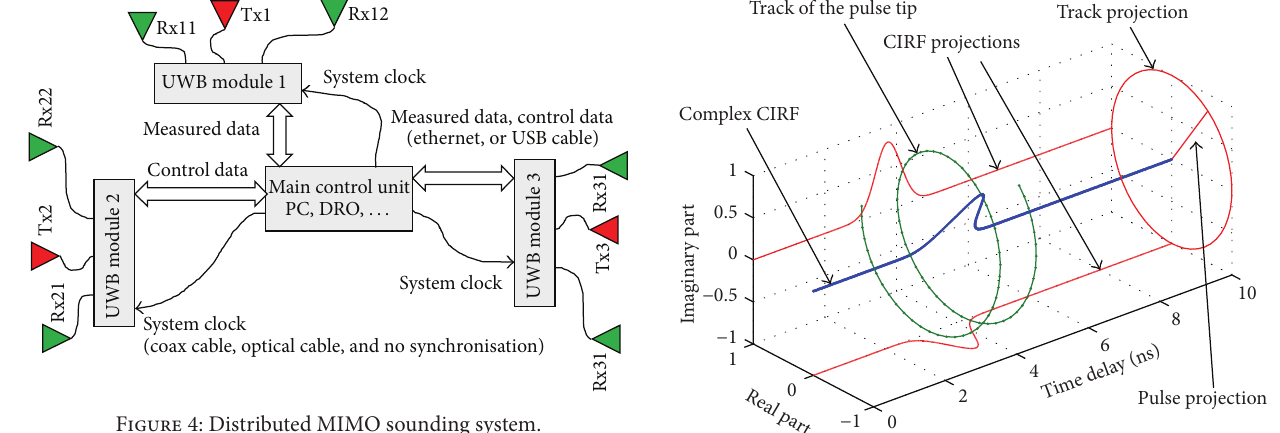
Figure 4: Distributed MIMO sounding system.